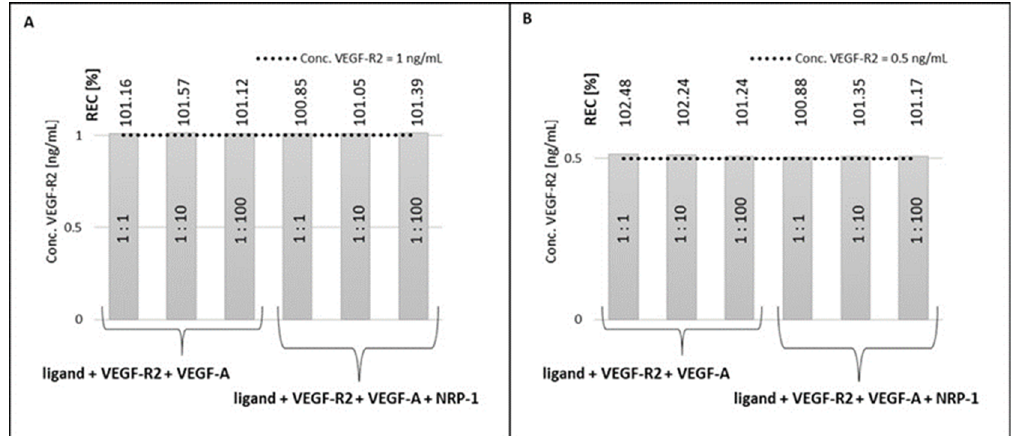
Figure 6. Selectivity of the developed methods, potential interferent reactions with ligand bound VEGF-R2. ( A ) gold chip; ( B ) bimetallic chip.